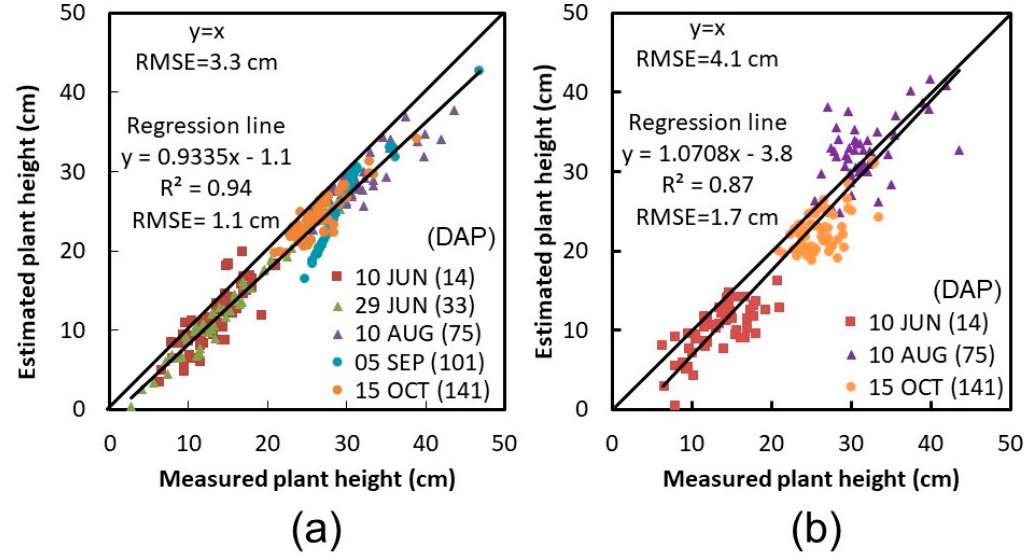
Figure 7. The Measured versus estimated values of sweet potato plant heights during different growth periods; ( a ) 28 mm lens derived data; ( b ) 50 mm lens derived data.